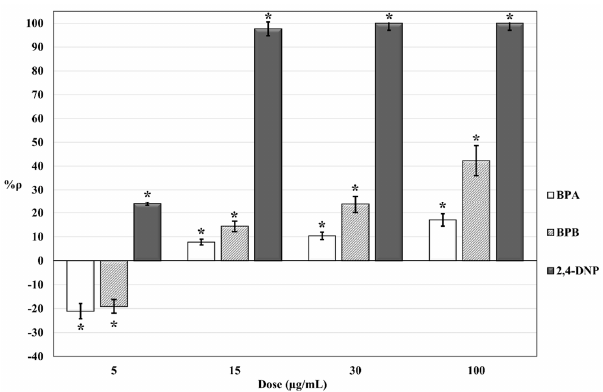
Figure 1. Dose-effect histogram of 24 h exposure of S. cerevisiae cell suspensions to BPA, BPB, and 2,4-DNP. %RSD ≤ 15%; ANOVA testing using randomized block design was applied for statistical differences between means values of Δ ppm O 2 exp and Δ ppm O 2 blk . Statistical significance of the results is indicated with asterisks (* p ≤ 0.05). Statistical tests were done using ANOVA testing for randomized bock design. A significant relationship between the mean variation of dissolved O 2 in exposed and control S. cerevisiae cell suspensions ( Δ ppm O 2 exp and Δ ppm O 2 blk , see section 4.2) was found at all concentrations tested ( p ≤ 0.05). The use of randomized block design of ANOVA testing helped to reduce possible confounding factors that may affect the comparison between data acquired in different days of testing, e.g., possible differences between stock yeast cell suspensions prepared on different days. Negative values of % ρ are expected to indicate an increase in cellular O 2 consumption in the exposed S. cerevisiae cell suspensions (compared to control cell suspensions) due to hyperstimulation of mitochondrial activity. Positive values are expected to indicate a decrease in cellular O 2 consumption in the exposed S. cerevisiae cell suspensions (compared to control cell suspensions) related to inhibition of mitochondrial activity. Long-term exposure of S. cerevisiae cells to increasing doses (from 5 to 100 µg/mL) of bisphenols determined an increase of % ρ from negative values, i.e., hyperstimulatory effect dominates (% ρ = − 21,04% and % ρ = − 19.05% for exposure to 5 µg/mL BPA and 5 µg/mL BPB, respectively), to positive values (for bisphenol concentrations ≥ 15 µg/mL), i.e., inhibitory effect dominates. Same doses of 2,4-DNP shown a higher toxic potency (compared to bisphenols). Short-term (4 h and 9 h) exposures to 5 µg/mL 2,4-DNP were performed (Figure 2).